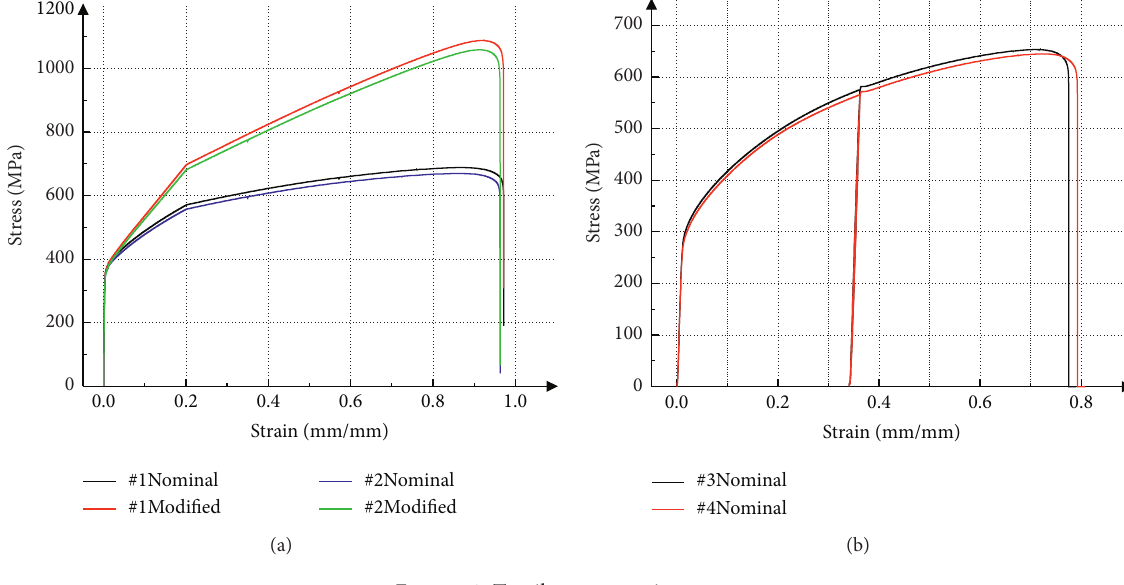
Figure 4: Tensile stress-strain curves.